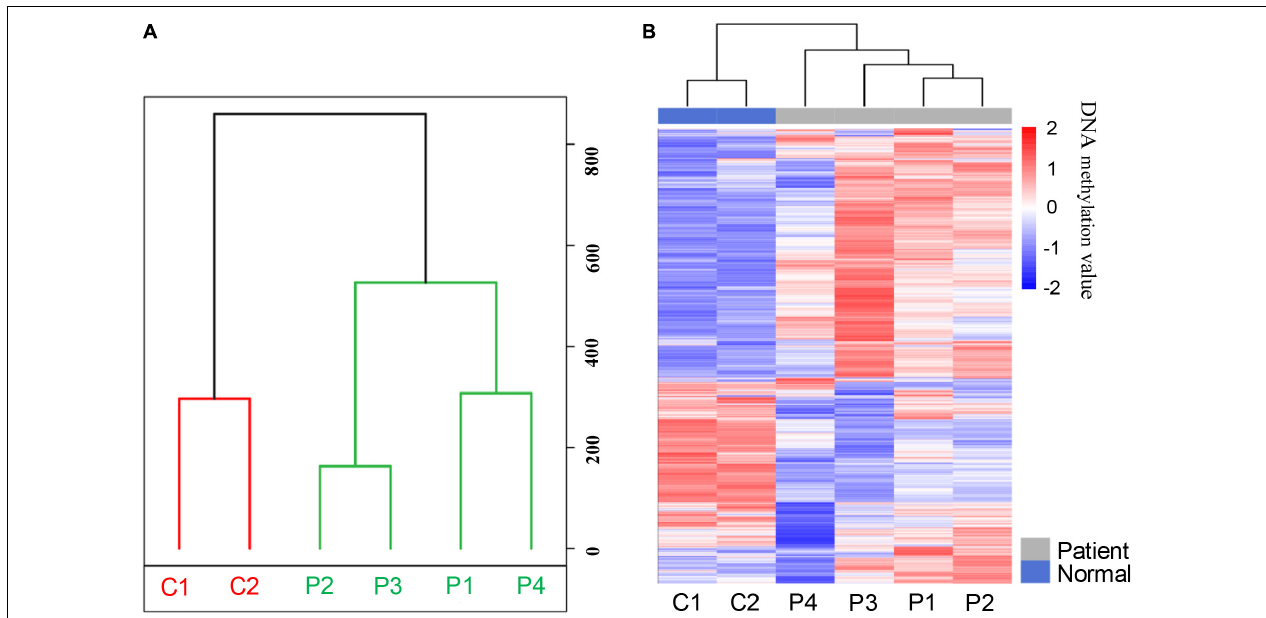
FIGURE 2 | The methylation patterns of pancreatic cancer patients and healthy controls after MeDIP-seq datasets analysis. (A) Principal component analysis (PCA) of the methylation profiles between patients and controls. (B) The unsupervised cluster analysis of the genome-wide methylation profiles in patients and controls.